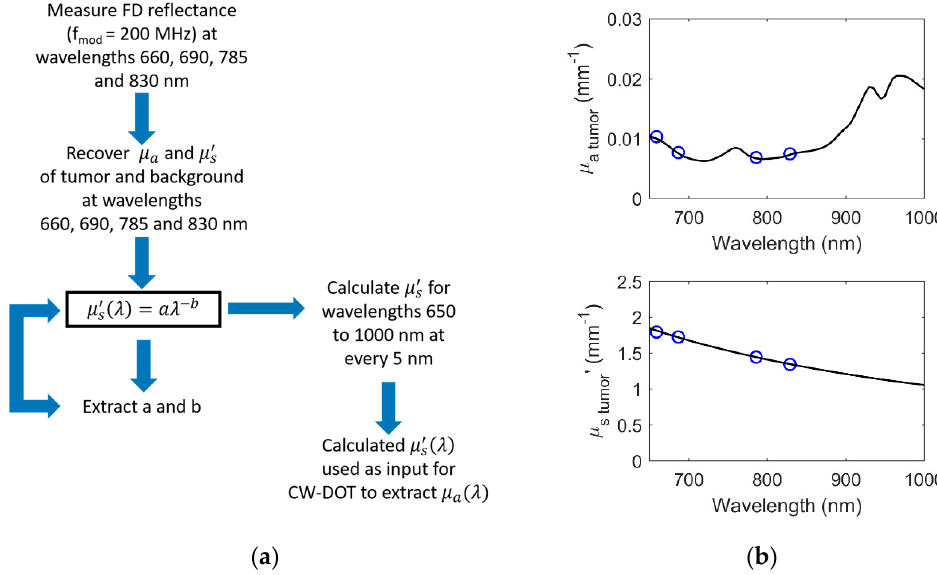
Figure 1. Hybrid frequency-domain (FD)- and CW-DOT (Continuous Wave-Diffuse Optical Tomography) method ( a ) overview and ( b ) example.